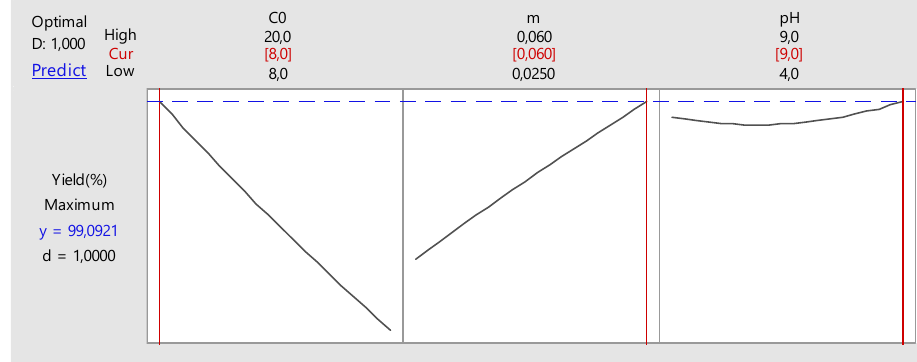
Figure 10. Diagrammatic optimization of MB removal parameters.